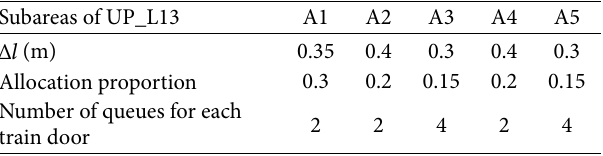
Table 2: Parameters for subareas of